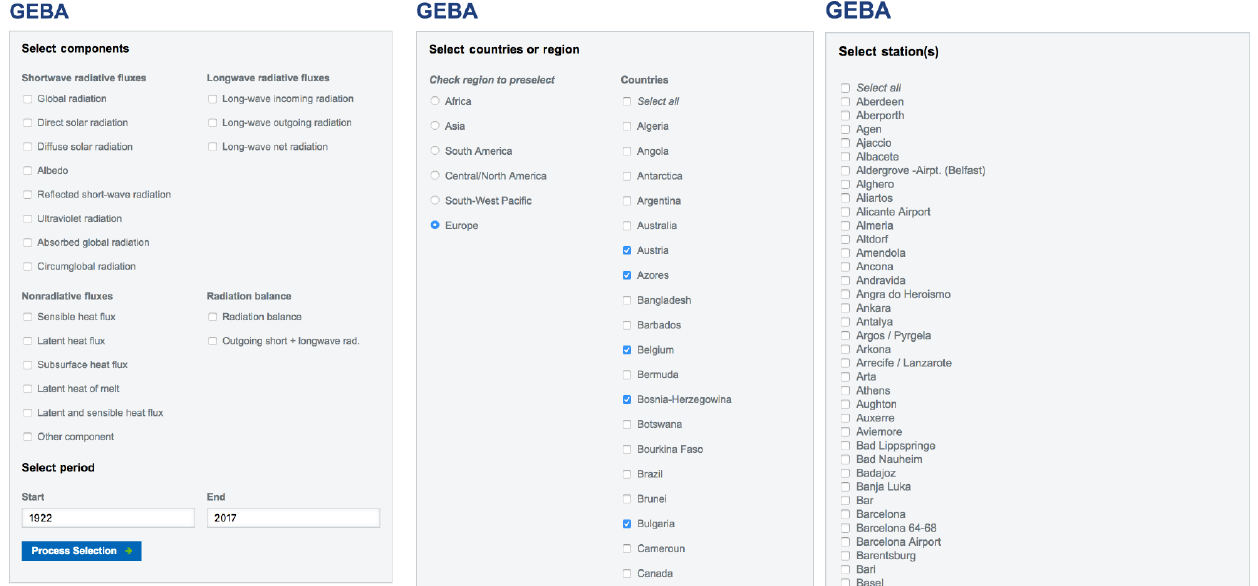
Figure 3. Example extract from the new GEBA web interface at www.geba.ethz.ch. The web interface allows the selection of a variety of surface energy balance components; the period to be retrieved; and the region, country, or specific stations of interest.